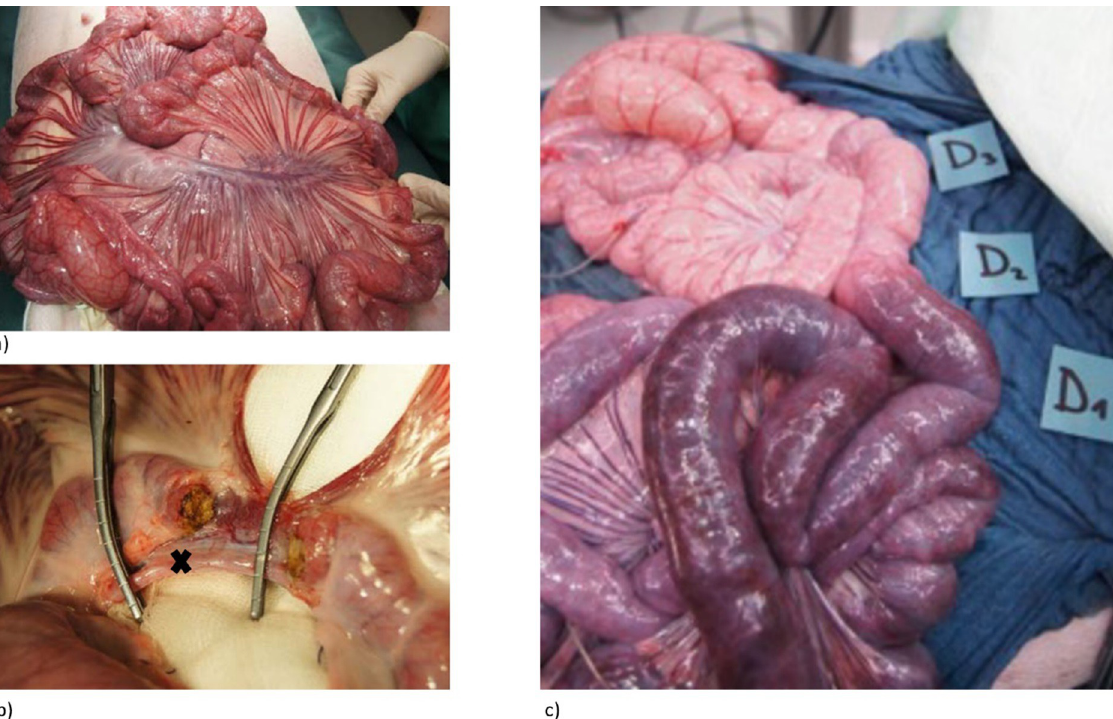
Fig 1. Model of mesenteric ischemia. A standardized model for mesenteric ischemia was previously established in an unpublished pilot study. Briefly, a huge branch of the superior mesenteric artery (SMA) was dissected in the meso-ileum. Due to huge venous and arterial collateralization in pigs (a), a complete dissection of the depending mesentery was performed, including the mesenteric vein and its venous weave (b). Afterwards the dissected branch of superior mesenteric artery ( ✖ ) is clamped to induce ischemia. For detailed evaluation, 3 ROIs were defined in ischemic (D1), transitional (D2), and control areas (D3), corresponding to the degree of ischemia (c).